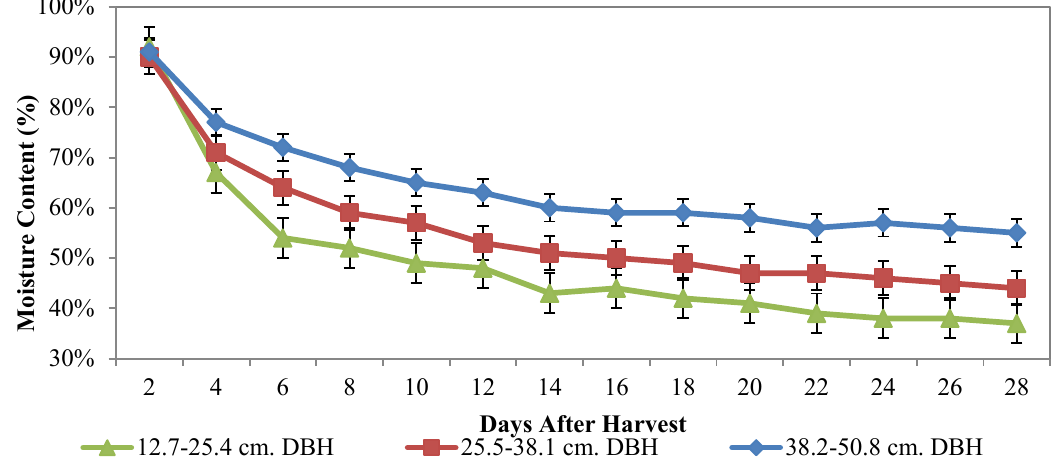
Figure 2. Moisture content (MC) of stem wood, dry weight basis, over 28 days following harvesting; mean MC values for trees on a given sampling date are shown as solid shapes averaged across both harvest systems, and error bars show one standard error (SE).